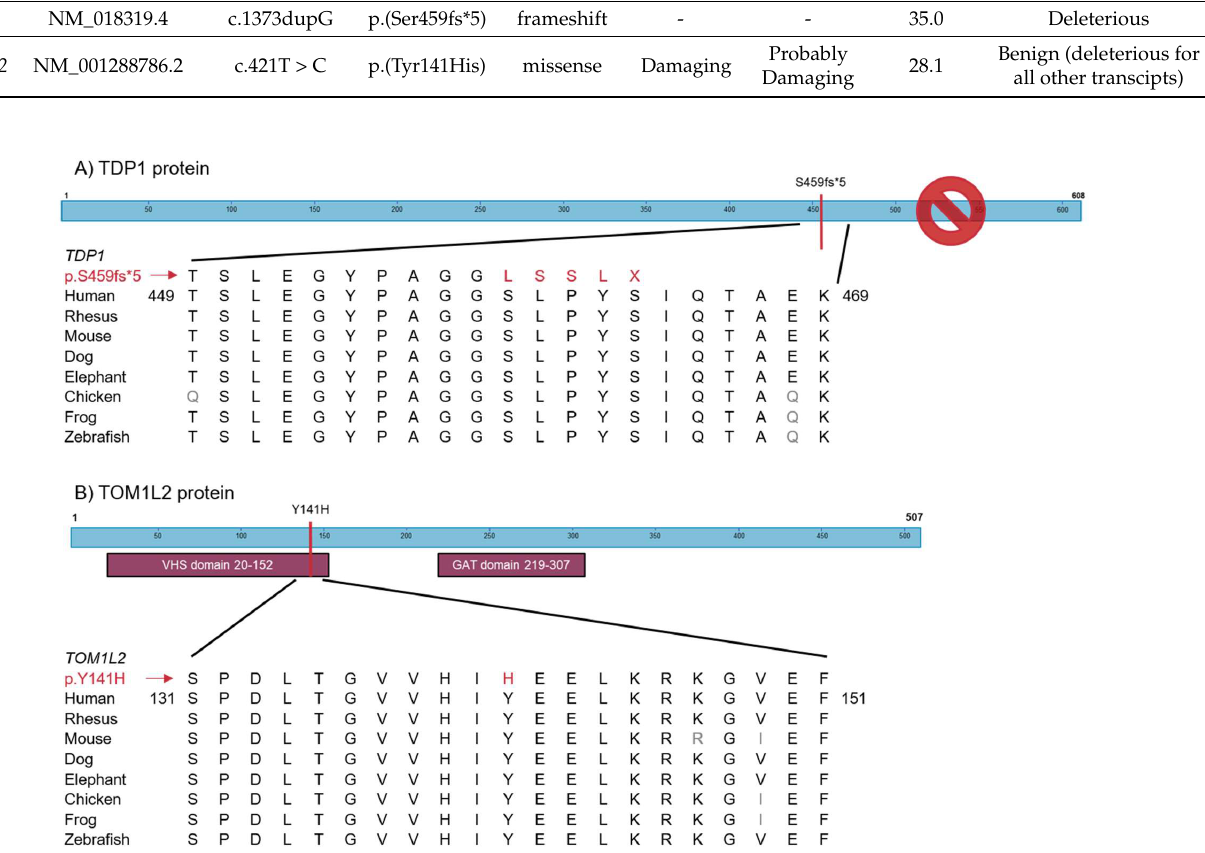
Figure 3. ( A ) Schematic representation of the TDP1 protein and amino acid conservation around the c.1373dupG p.(S459fs*5) variant. The variant is predicted to cause a frameshift resulting in a premature stop codon (X); ( B ) Schematic representation of the TOM1L2 protein with its two functional domains. The predicted p.(Y141H) amino acid alteration caused by the c.421T > C variant is located in the VHS domain. Amino acid conservation around novel variants in TDP1 and TOM1L2 across eight species with the conserved residues in black and the new variants in